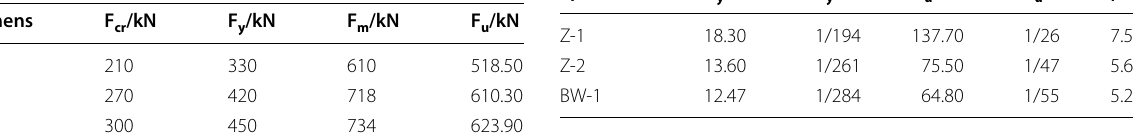
Table 5 Bearing capacity of three specimens.